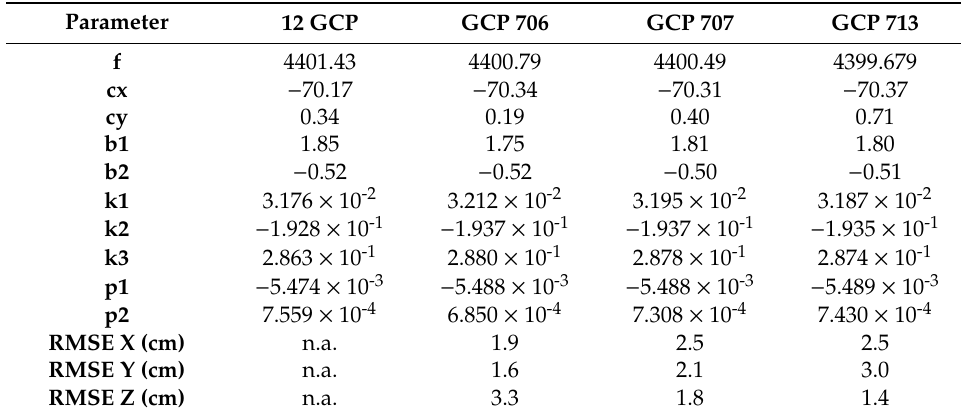
Table 3. Calibration parameters of the eBee camera obtained by fixing 12 GCP or a single GCP in the calibration adjustment; RMSE on the 9 CP coordinates in the single GCP